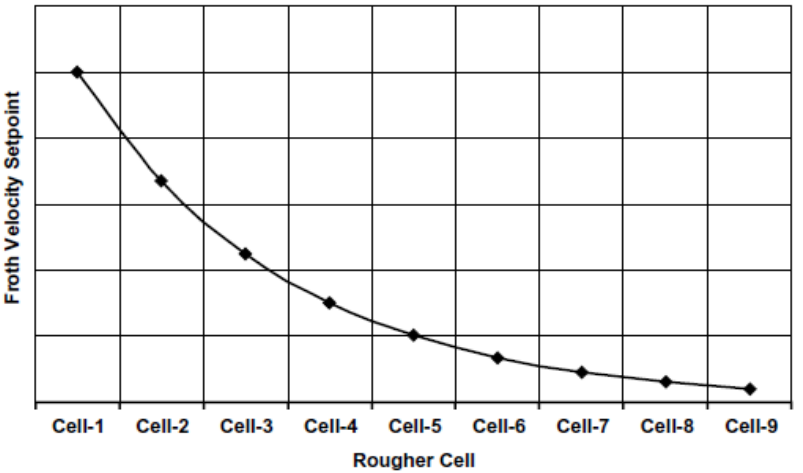
Figure 3. Illustration of the froth velocity set-point profile targeted by PT Freeport